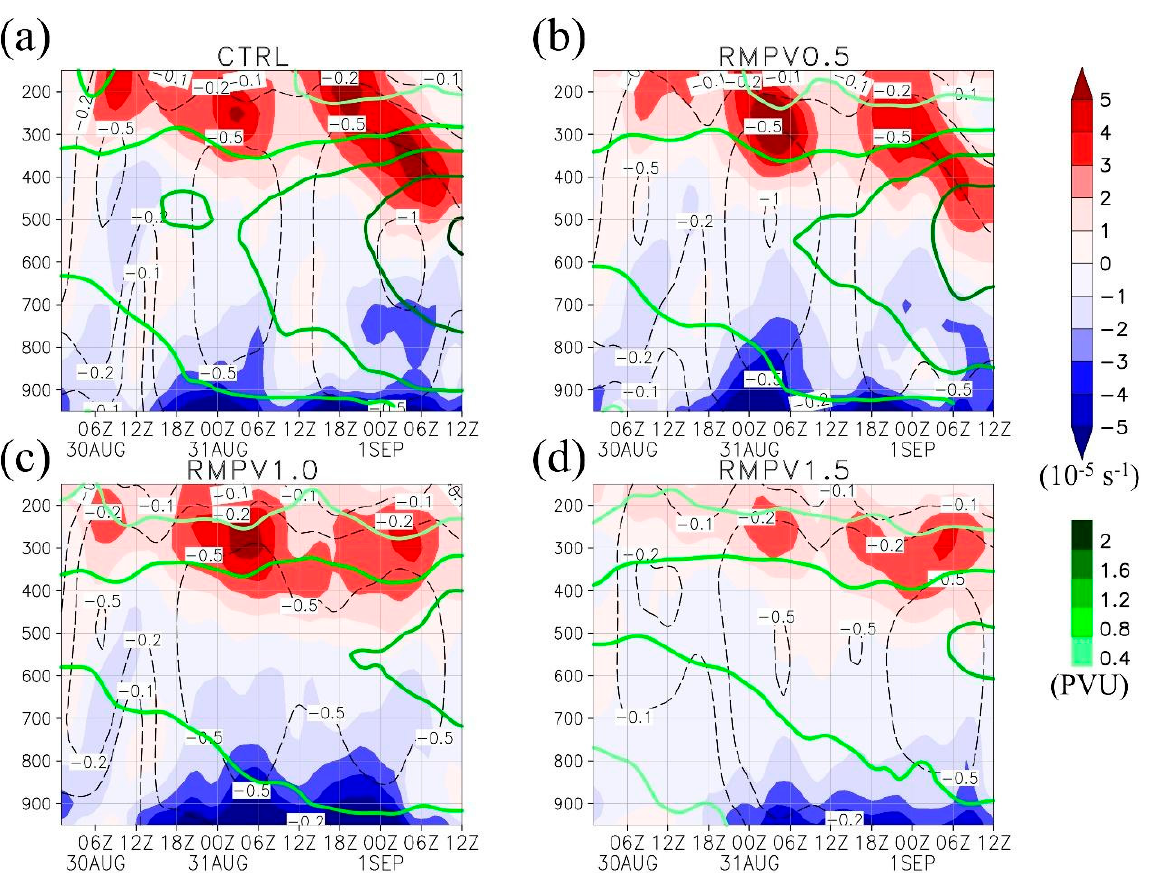
Figure 12. Time-height section of the divergence (shading; 10 − 5 s − 1 ), vertical velocity (black contours; Pa s − 1 ) and PV (green contours; PVU) averaged over a 2°-radius area centered at 700 hPa vortex center in every 1 h in ( a ) CTRL, ( b ) RMPV0.5, ( c ) RMPV1.0 and ( d ) RMPV1.5. The unit of the y-axis is hPa, and the time ranges from 0000 UTC 30 August ( − 24 h) to 1200 UTC 1 September (+36 h). In general, it turns out to be indistinguishable in CTRL, RMPV0.5 and RMPV1.0 for the fi rst event, including from 600- to 400-hPa PV value (0.8 to 1.2 PVU in average) and